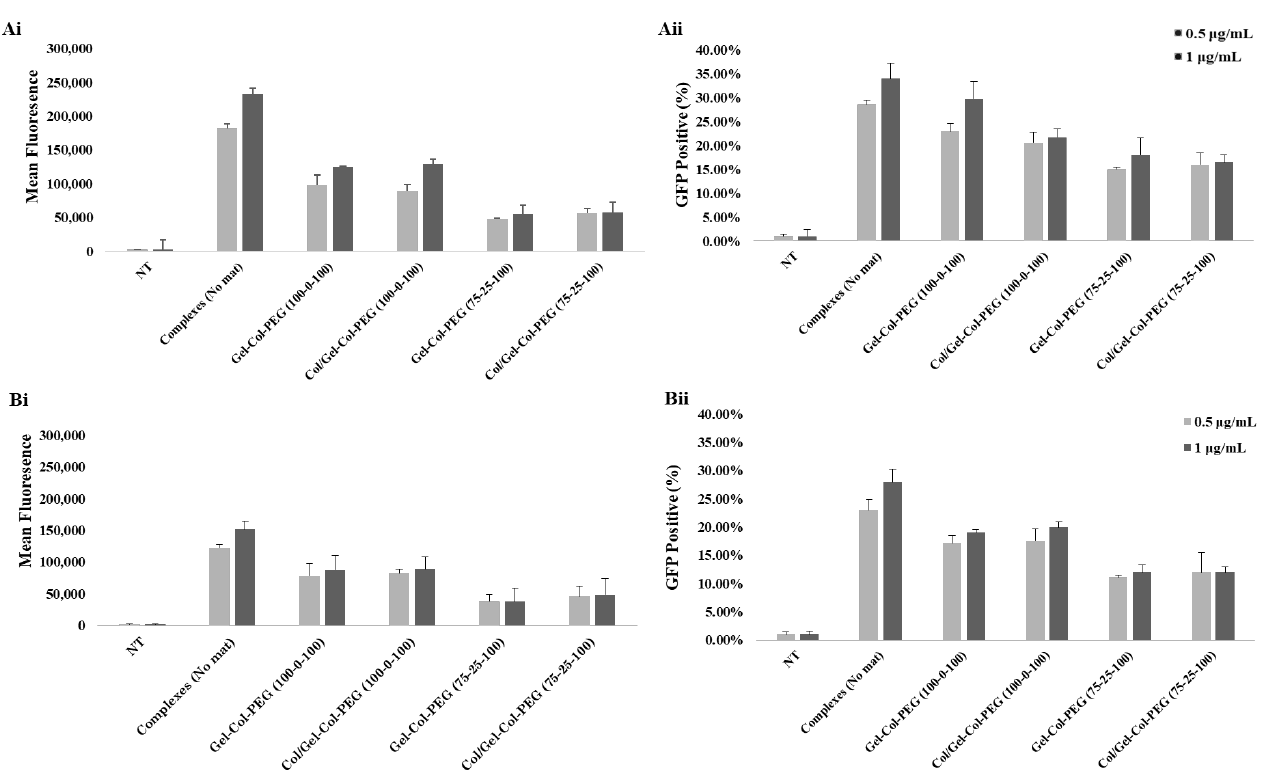
Figure 6. GFP expression by C2C12 ( Ai , Aii ) and MC3T3 ( Bi , Bii ) cells treated with monolayer mats Gelatin-Collagen-PEG (100-0-100) and (75-25-100) and double layered Collagen/Gelatin-Collagen-PEG (100-0-100) and (75-25-100) mats containing GFP complexes. The transfection efficiency was summarized as GFP-positive population ( Ai , Bi ) and as mean fluorescence intensity/cell ( Aii , Bii ) 48 h post-transfection by flow cytometry analysis. The GFP concentrations in cell culture medium were 1.0 and 0.5 μg/mL. NT: no treatment.